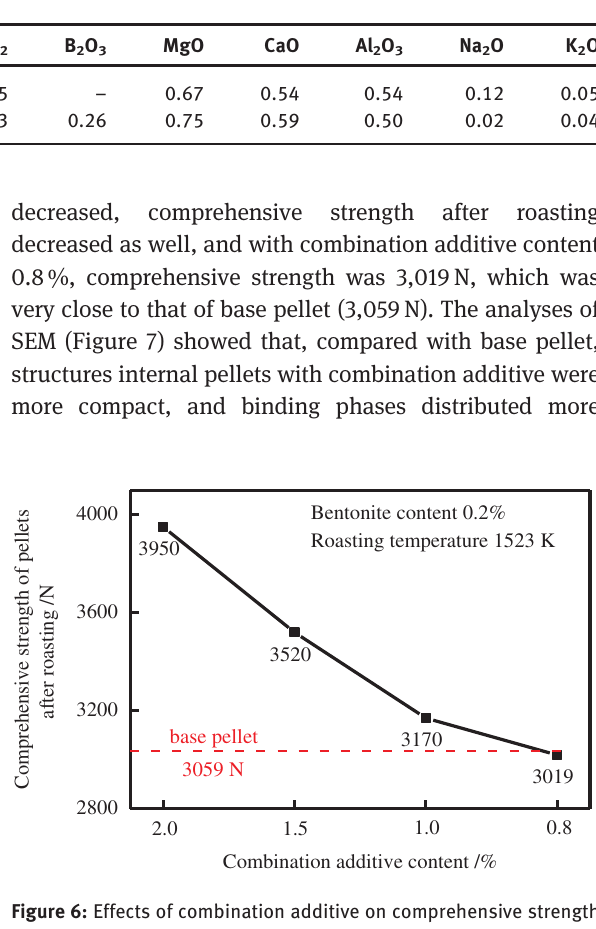
Table 3: Chemical compositions of pellets after roasting/%.